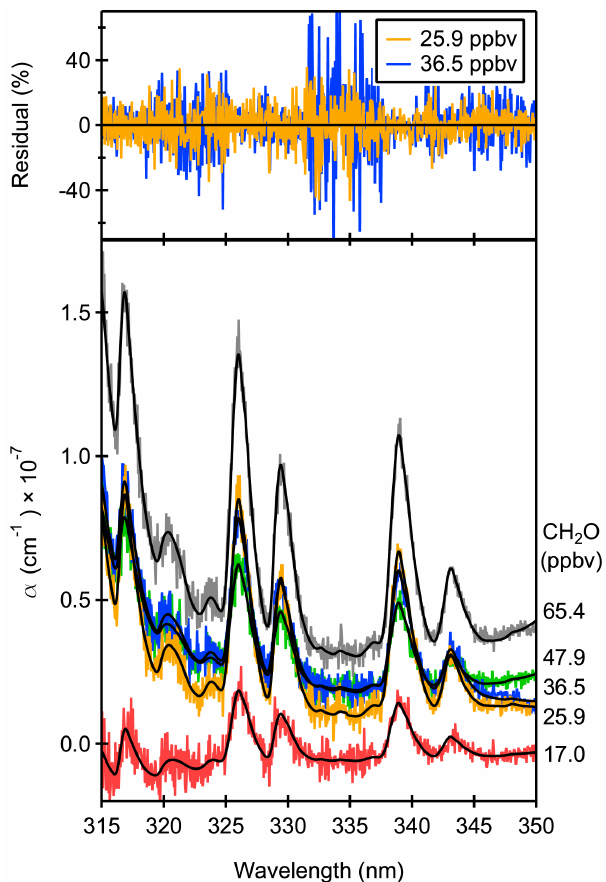
Figure 5. Measured α(λ) and calculated spectral fits for CH 2 O concentrations from 17 to 65ppbv. Two fit residuals are shown in the upper panel. The average fit uncertainty for all concentrations shown is 400pptv CH 2